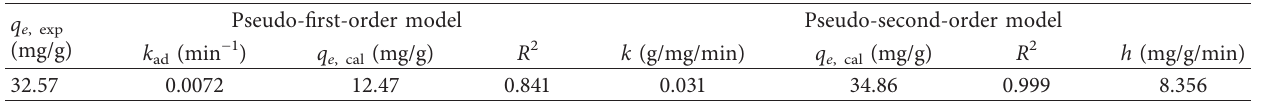
Table 6: Kinetic adsorption parameters for As(V) adsorption.